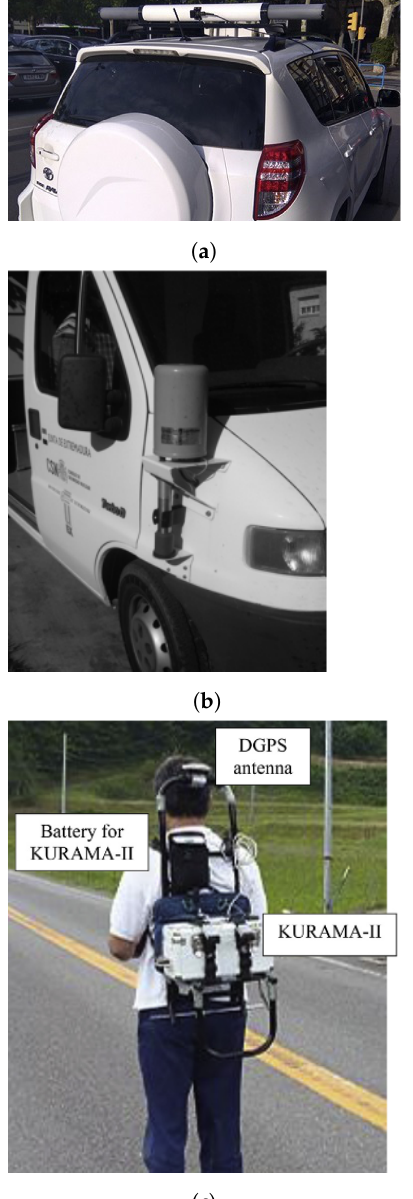
Figure 6. Examples of ground-based mobile detection systems: ( a ) Car-borne survey with two LaBr 3 mounted in the roof. Reproduced, with permission, from Reference [124]; published by Elsevier, 2020, under the terms of the https://creativecommons.org/licenses/by/4.0/CC BY 4.0 license. ( b ) Van with a dose rate counter (top) and a NaI(Tl) spectrometer (bottom). ©2013 IEEE. Reprinted, with permission, from Reference [125]. ( c ) Backpack KURAMA-II for walk surveys using a CsI(Tl) scintillation detector. Reproduced, with permission, from Reference [128]; published by Elsevier, 2018, under the terms of the https://creativecommons.org/licenses/by-nc-nd/4.0/CC